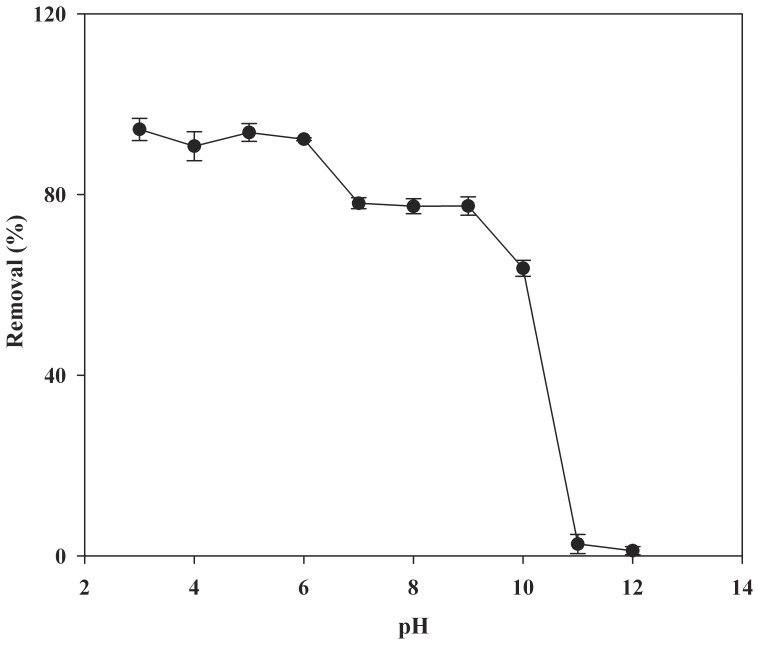
Effect of pH on the adsorption efficiency of CA by MIP (mean ±SD, n = 3).